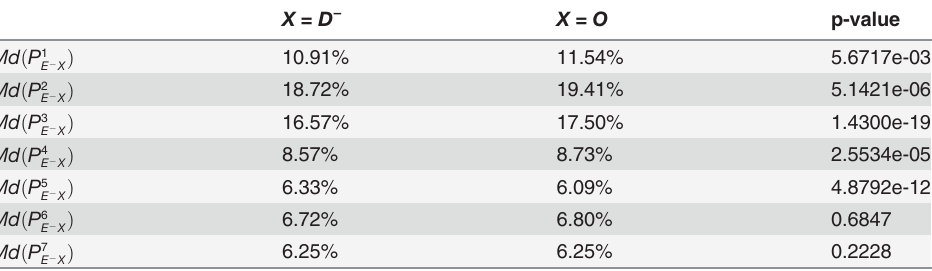
Table 5. Median values of the proportions of non-disease essential proteins among n ( n 2 {1, 2, 3, 4, 5, 6, 7}) neighbors of nonessential disease proteins ( D − ) and other proteins ( O ) in the protein interaction network constructed based on the STRING